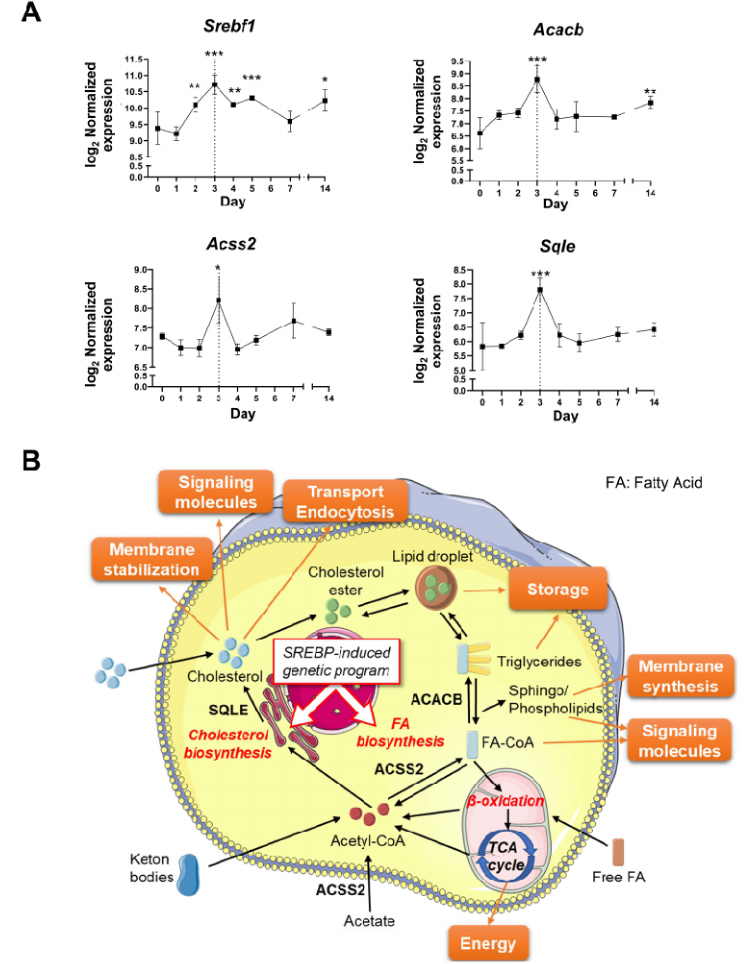
Figure 6. During the resolution of inflammation, both fatty acid and cholesterol biosynthesis pathways are activated. ( A ) The expression level of key genes in lipid metabolism reached a peak on day 3 after injury, according to RNA-seq data. Error bars show the mean (SD). Significant differences are represented as * if p value p < 0.05, ** if p < 0.01, and *** if p < 0.001. ( B ) In a normal cell, lipid metabolism is regulated by SREBP proteins and encompasses multiple reactions that generate lipids for three main purposes: (1) as source of energy, (2) as membrane constituents, and (3) as signaling/regulatory molecules. (1) Energy is mainly produced by oxidative metabolism through the TCA cycle in the mitochondria. The first step of the TCA cycles uses acetyl-coenzyme A (acetyl- CoA) to generate citrate. Mitochondrial acetyl-CoA can be generated from lipidic sources: by the breakdown of ketone bodies or by the β -oxidation of fatty acyl-CoA (FA-CoA). FA-CoA is obtained by the activation of fatty acids (FAs), which were either synthetized de novo, imported into the cells as free FAs, or obtained by the hydrolysis of triglycerides or cholesterol esters. Triglycerides and cholesterol esters are used for lipid transport or intracellular storage as lipid droplets. (2) Cellular membranes are mainly composed of sphingolipids, phospholipids, and cholesterol, and their respective proportions modulate membrane properties (e.g., lipid rafts). (3) Cholesterol is necessary for the synthesis of steroid hormones and vitamin D, while polyunsaturated fatty acids (PUFAs) are precursors for pro-inflammatory eicosanoids (e.g., leukotrienes, prostaglandins) and specialized pro-resolving mediators (e.g., resolvins, lipoxins). Membrane lipids can also be converted into signaling molecules (e.g., PIP2 → DAG +IP3). After acute injury, upregulation of Srebf1 encoding SREBP1 promotes the transcription of enzymes involved in the synthesis of acetyl-CoA, fatty acids, and cholesterol including ACSS2, ACACB, and SQLE, respectively. This scheme was partly generated using Servier Medical Art, provided by Servier, licensed under a Creative Commons Attribution 3.0 unported